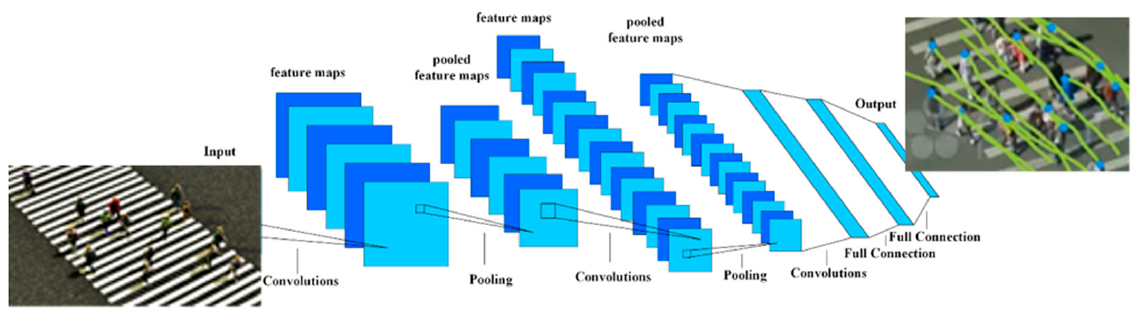
Figure 10. CNN-typical architecture: input, multiple convolutional + ReLU activation function, (max) pooling, flatten, fully connected and SoftMax outputs layers.